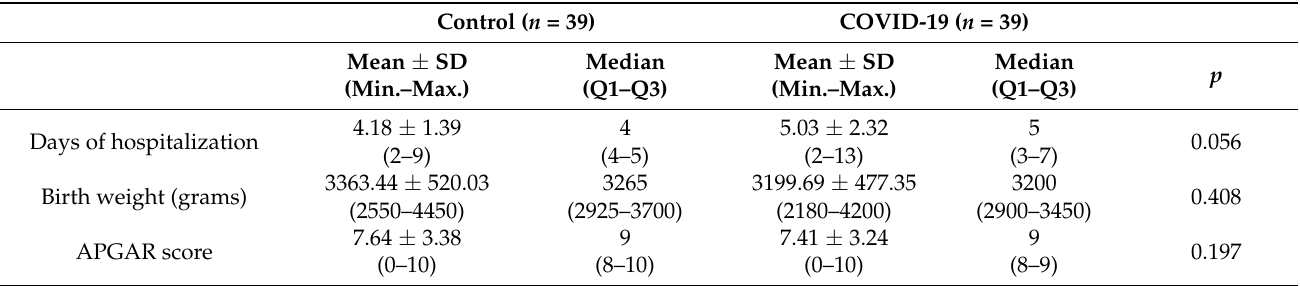
Table 4. Comparison between days of hospitalization, birth weight, and APGAR score, between the COVID-19-positive and control groups.